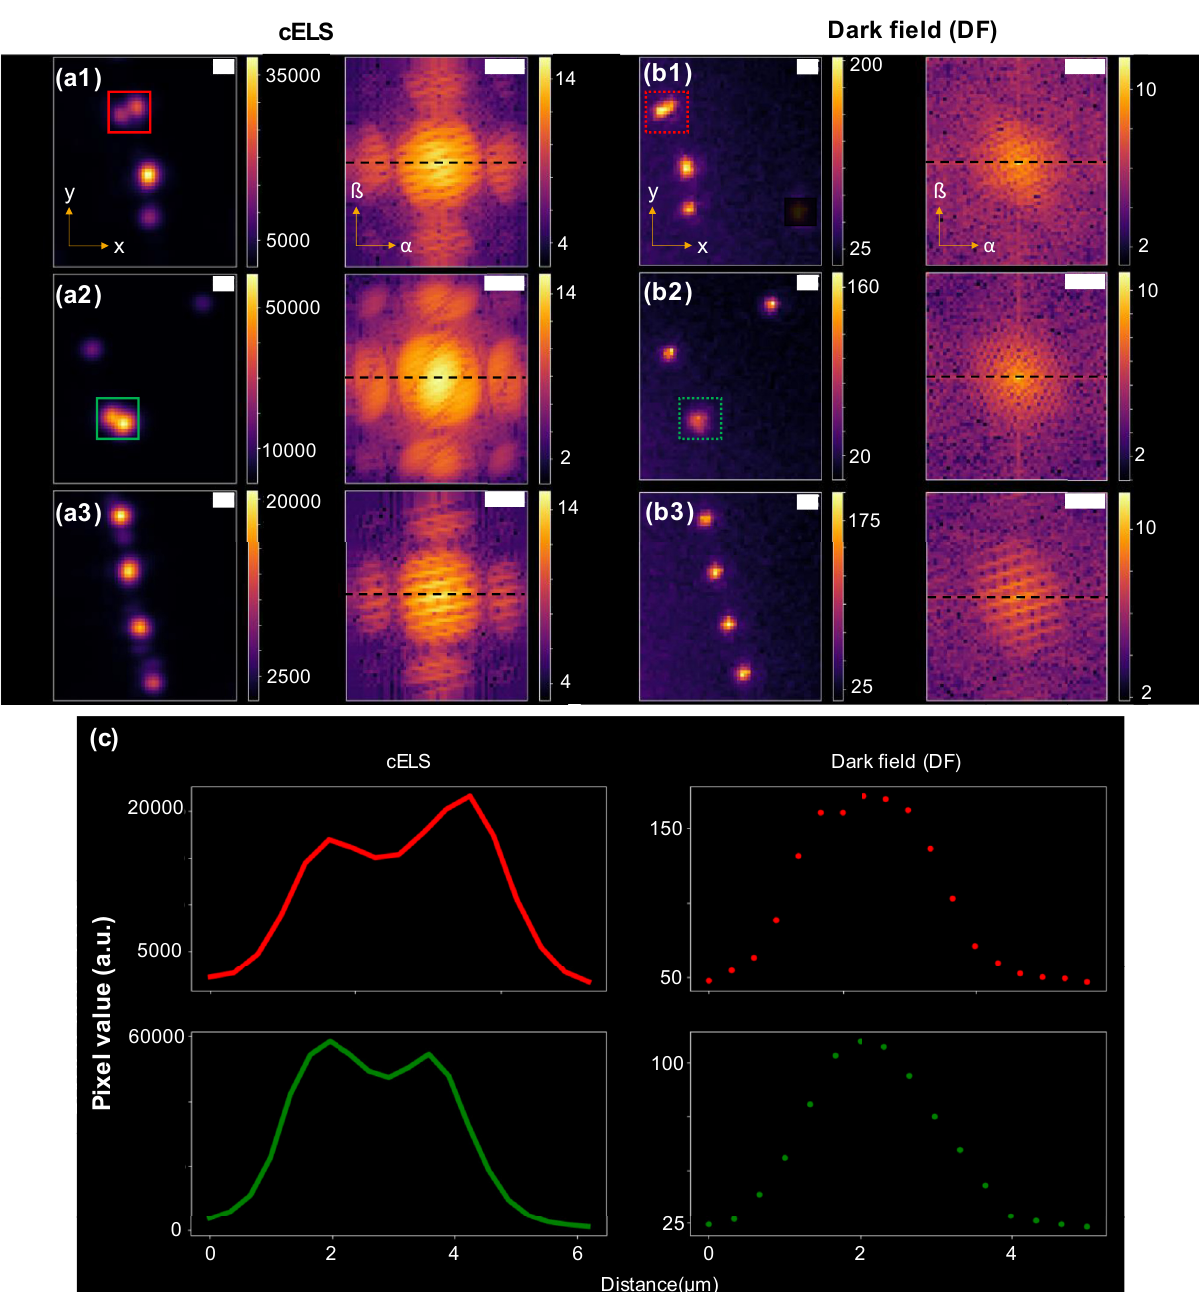
Figure 5: Comparison of 100 nm gold nanoparticles (GNP) imaged using cELS and dark-field (DF) microscopy. (a1)–(a3) Averaged image ( x – y plane) of 100 nm GNP of three different regions of interest imaged in cELS mode and acquired using a 10X/0.25 NA MO. Their corresponding Fourier spectrum ( 𝛼 – ß plane) is shown alongside. (b1)–(b3) 100 nm beads imaged ( x – y plane) using a DF microscope with 10 × /0.3 NA and their corresponding Fourier spectrum ( 𝛼 – ß plane) is shown. The colorbars indicate the pixel values in the real image ( x – y plane). In the Fourier images ( 𝛼 – ß plane) the colorbars indicate logarithm of the pixel values along the black dotted line. (c) Line plots of the cELS and DF images are shown. The line plots given by the red and green lines correspond to the boxes in (a1)–(a2) and are for the cELS images. The red and green dotted lines correspond to the dotted boxes in (b1)–(b2) and are for the DF images. To match the magnification between cELS and DF microscope, cELS images are bilinearly interpolated and displayed here. All the Fourier images are displayed on log scale for a better visualization. Scale bar 2 μ m in real space and 500 mm − 1 in Fourier